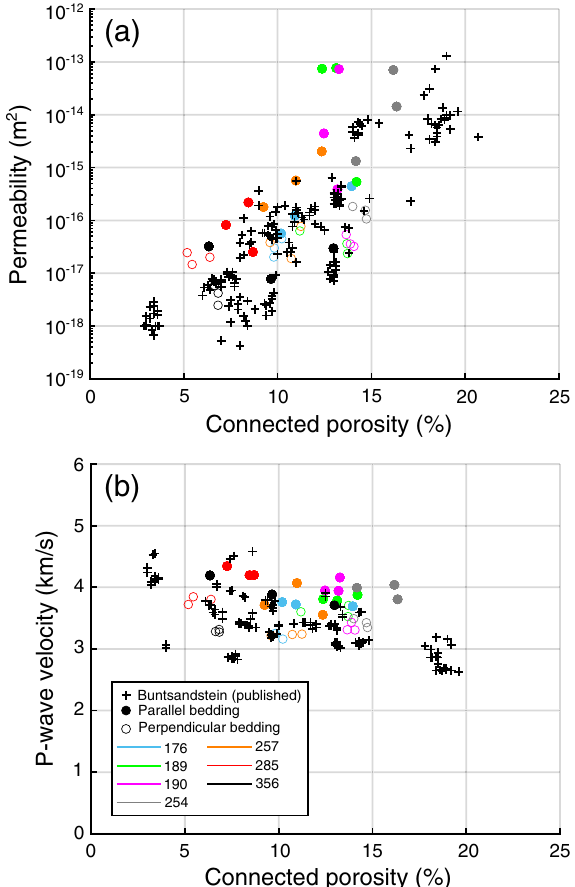
Fig. 11 a Permeability and b P-wave velocity as a function of connected porosity for the 42 samples of Buntsandstein sandstone prepared for this study, together with previously published data for Buntsandstein sandstone samples taken from EPS-1 (Soultz-sous-Forêts) (data from Griffiths et al. 2016; Heap et al. 2017, 2019a; Kushnir et al. 2018b). Samples were prepared either parallel (filled circles) or perpendicular (unfilled circles) to bedding. The number refers to the box